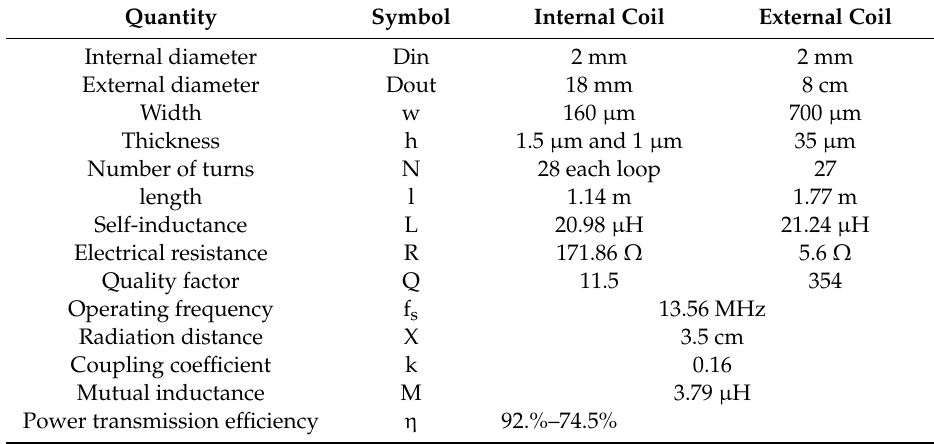
Table 2. Analytical results for the designed internal and external coils.